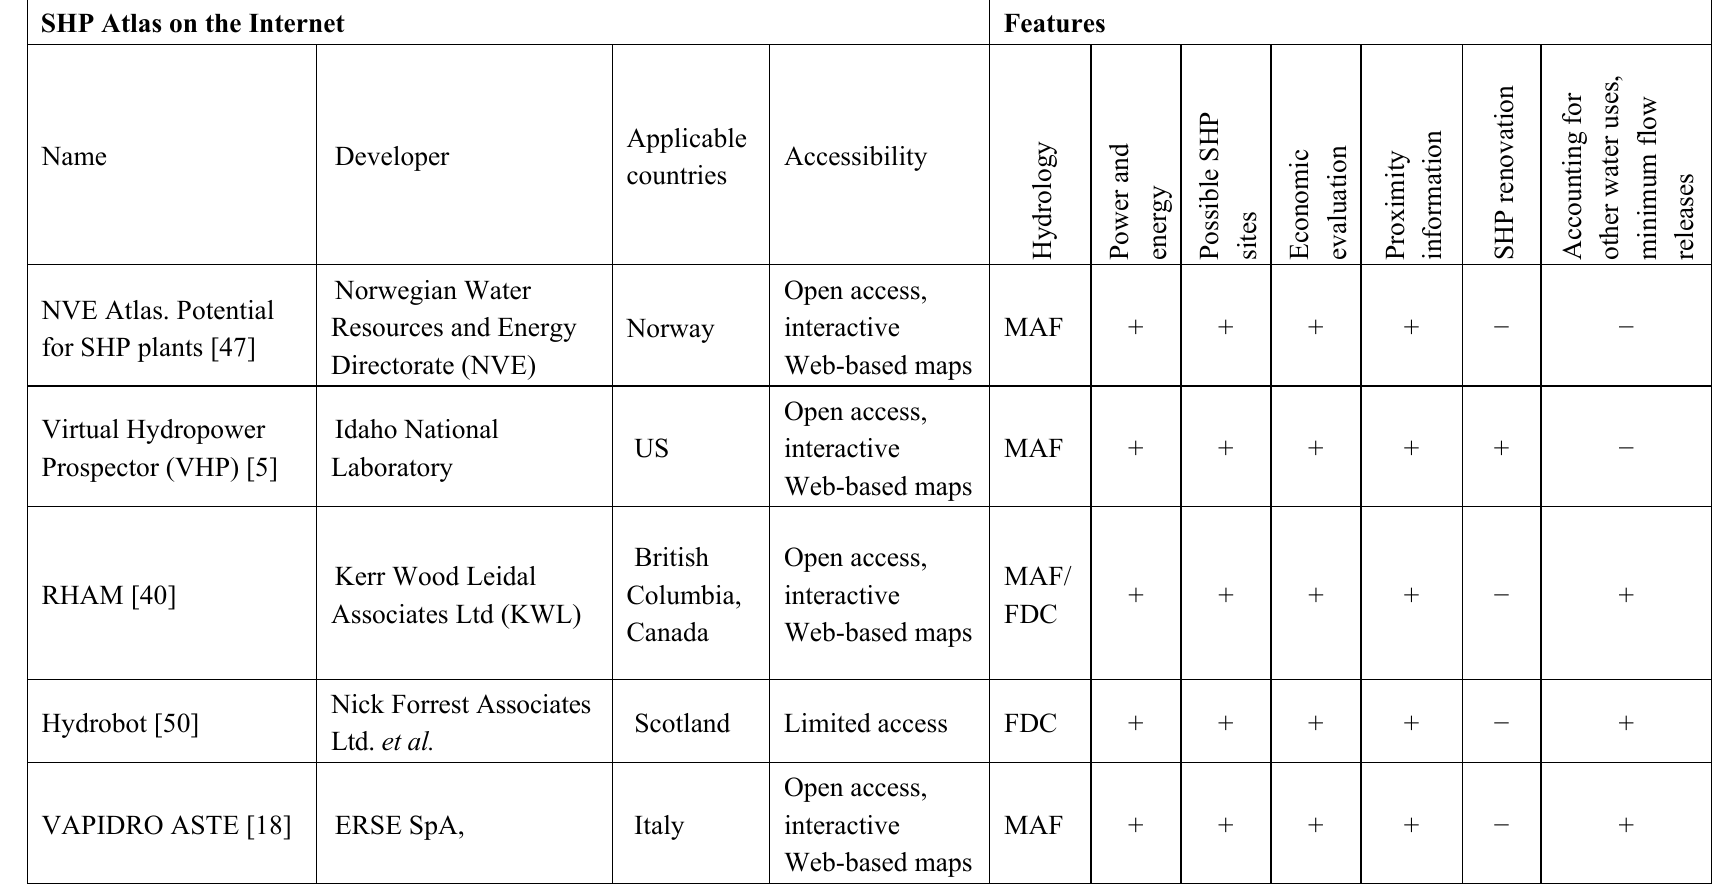
Table 3. GIS-based Small Hydropower Atlases on the